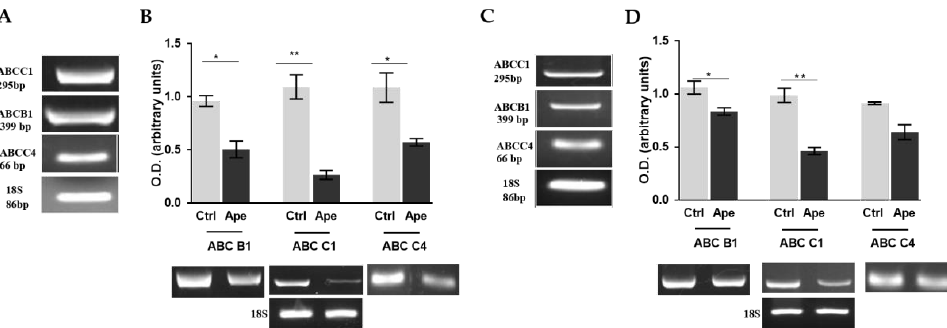
Figure 7. RT-PCR analysis showing the ABC-B1, ABC-C1 and ABC-C4 transcript levels in SK-N-BE ( A ) and SK-N-BE(2C) cell lines ( C ). Here, 18S used as housekeeping gene. RT-PCR analysis showing the ABC-B1, ABC-C1 and ABC-C4 transcript levels in SK-N-BE ( B ) and SK-N-BE(2C) ( D ) cell lines after 24 h of treatment with 100 µM APE. The graphs indicate the densitometric analysis of the bands of the transcript normalized with the housekeeping gene 18S. The results are the average ± SEM of three independent experiments performed in triplicate. (* p < 0.05; ** p < 0.01; t -test; APE vs. respective Ctrl).